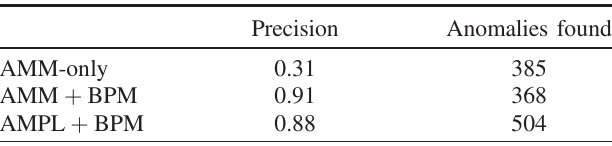
TABLE III. Precision and number of anomalies found using the AMM bit alone, AMM bit corroborated by BPMs, and AMPL corroborated by BPMs. The corroborated data use the BPM thresholds that maximize the F 1